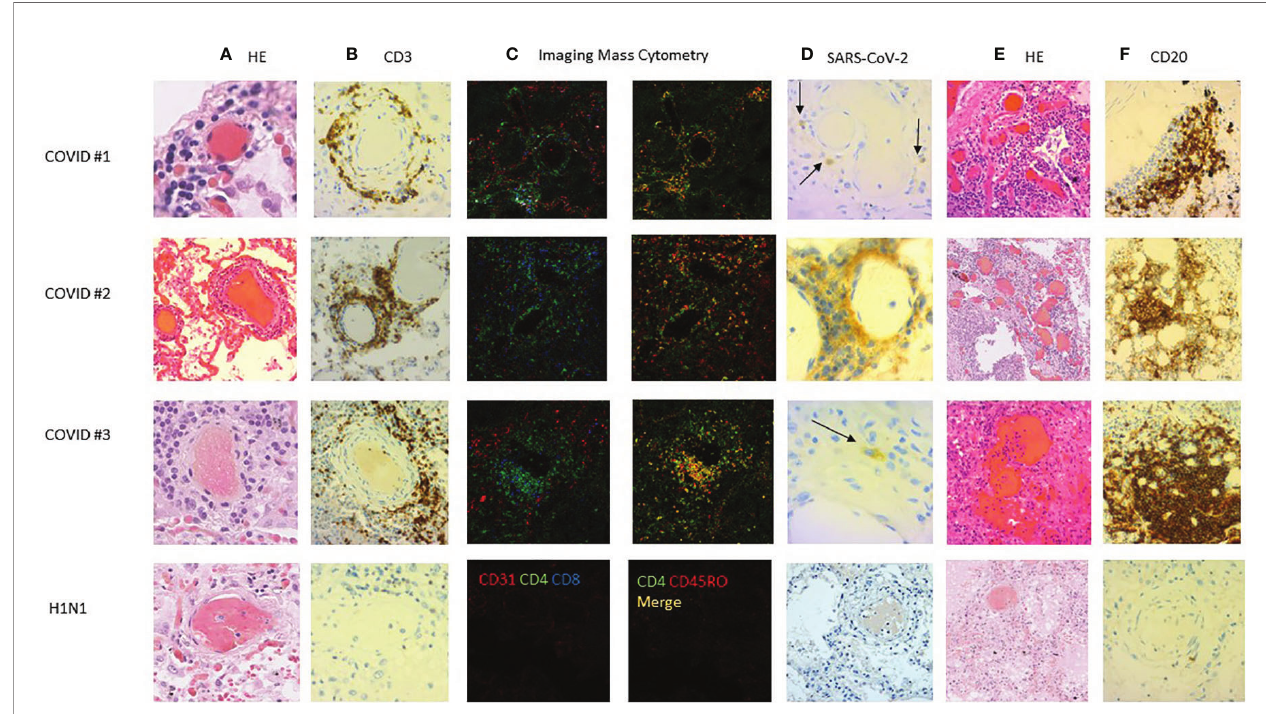
FIGURE 4 | Lung histopathology of deceased COVID-19 cases. Lung sections of three COVID-19 cases were studied with hematoxylin – eosin staining (HES) and immunostaining. (A) HES staining showed sparse (case #1) or abundant (cases #2 and #3) lymphocytic vasculitis of middle-sized pulmonary vessels. (B) The lymphocytic in fi ltration was mainly CD3 positive (C) and also CD45RO+CD4+ positive in imaging mass cytometry (C) . (D) Immunostaining showed SARS-CoV-2- positive cells around middle-sized vessels (arrows). (E) Some vascular formations were surrounded (F) by CD20+ lymphocytes accumulating in what could be a tertiary lymphoid structure. This perivascular in fl ammation was not observed in an in fl uenza H1N1 case (bottom